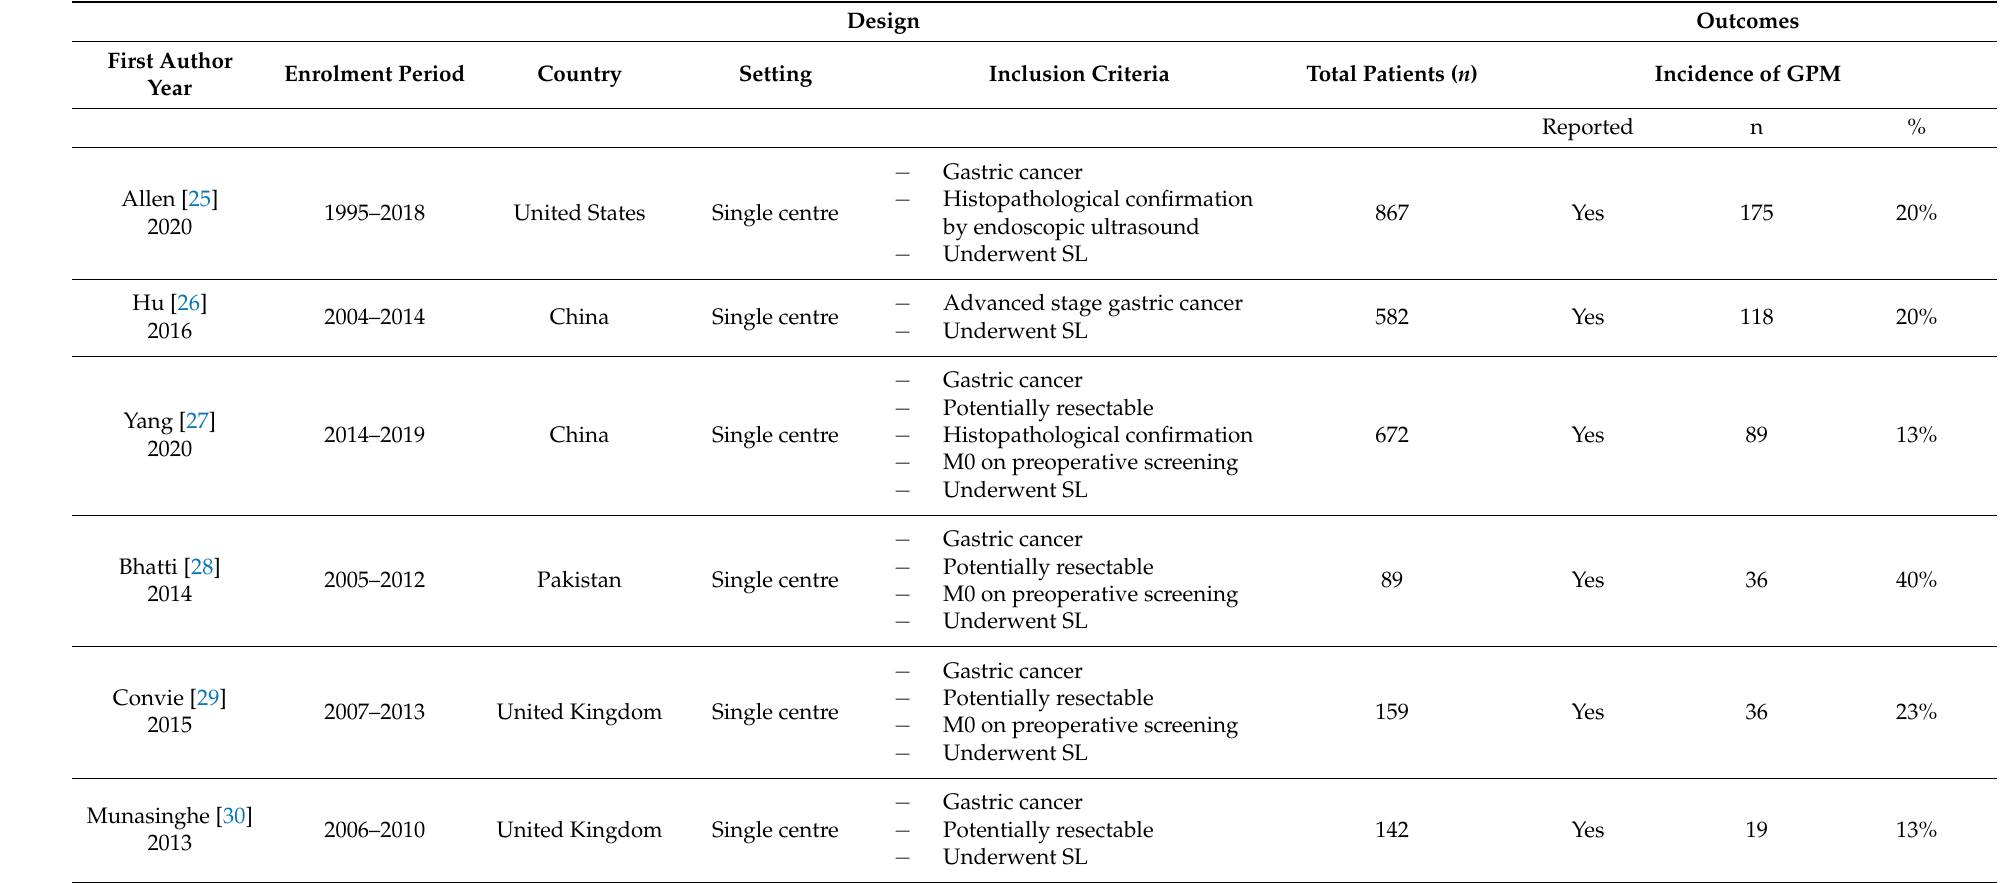
Table 2. Study characteristics of studies on gastric cancer and staging